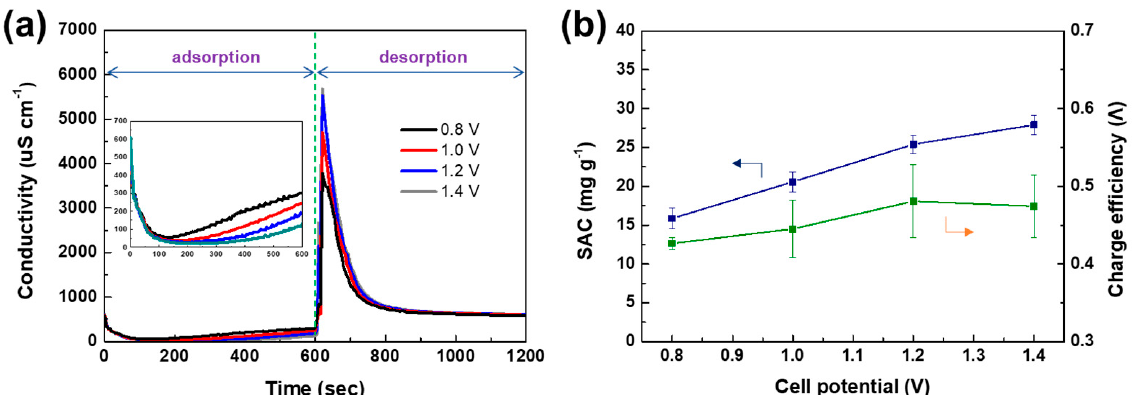
Figure 6. ( a ) Effluent conductivity of CsNO 3 according to the cell potentials during the adsorption process and ( b ) specific adsorption capacity of Cs + ions and charge efficiency (Experimental conditions: Influent of 200 mg L − 1 Cs + ions at pH 3 solution was fed with a flow rate of 20 mL min − 1 for 10 min adsorption/desorption, respectively).